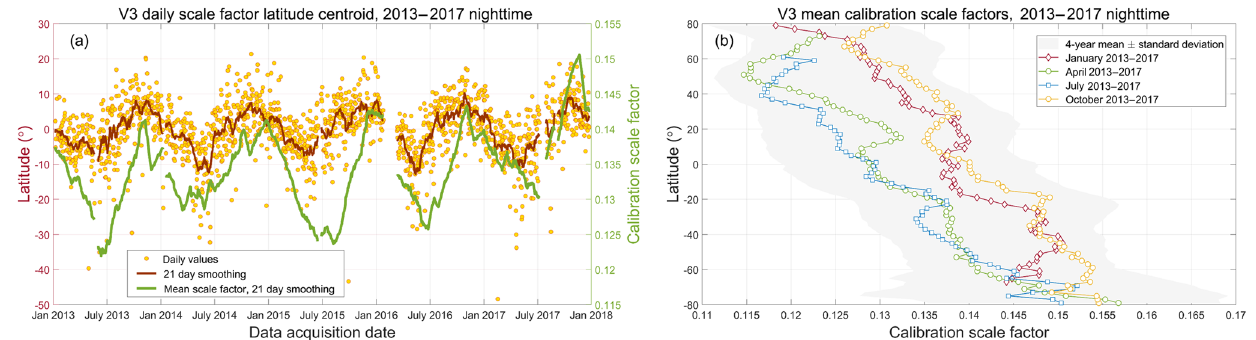
Figure 22. Panel (a) shows the V3 daily mean latitude centroids (orange circles) measured during 2013–2017. The dark red line shows a 21-day running average. The green line (associated with the right y axis) shows a 21-day running average of the daily mean V3 calibration scale factors (i.e., as in Eq. 2). Panel (b) shows the latitudinal variation of the mean scale factors during the same time period. The gray shaded area represents the 4-year mean ± 1SD, with individual lines showing monthly means for January (red diamonds), April (green circles), July (blue squares), and October (orange circles).